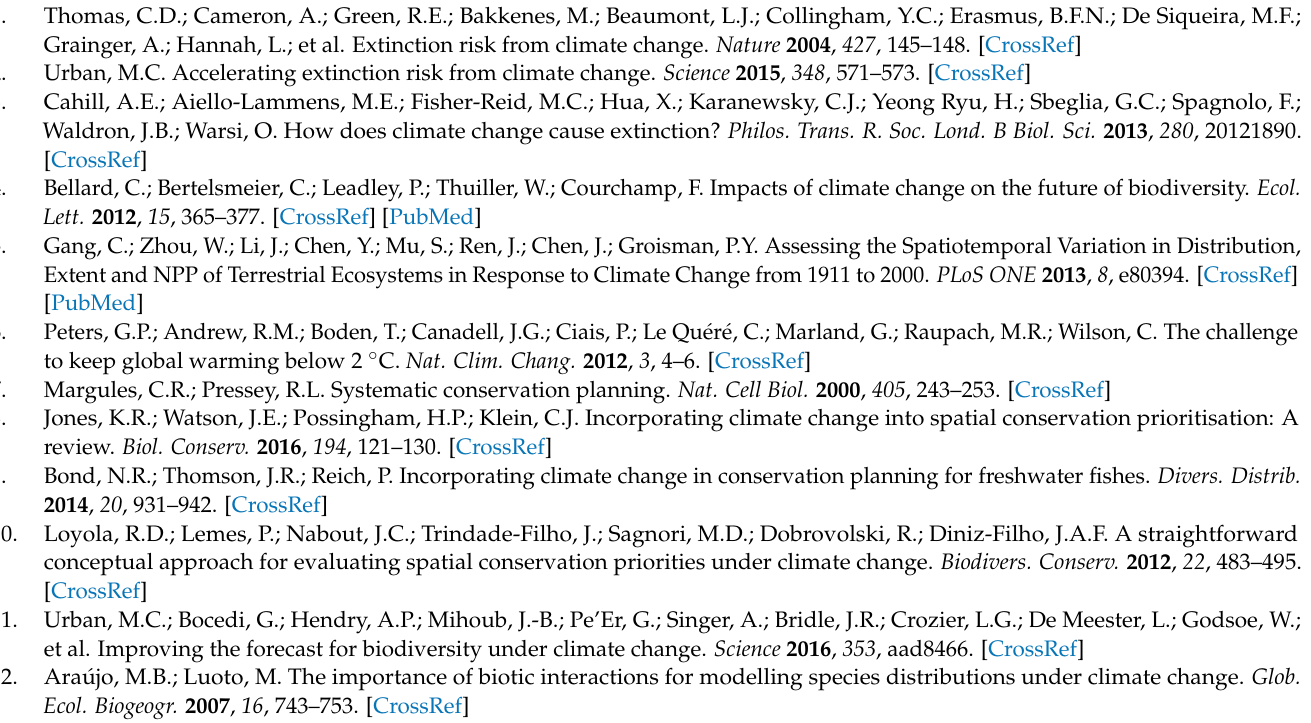
variables, Table S3: Datasets used in this study, Table S4: Classification model performance, Figure S1: Variability (as a measure of uncertainty) between the outcomes of different combinations of classification models and climate datasets used to generate montane forest